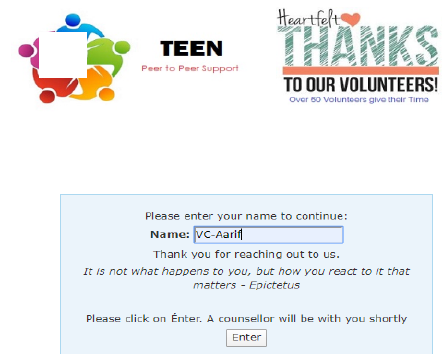
Figure 11. Landing page for Clients